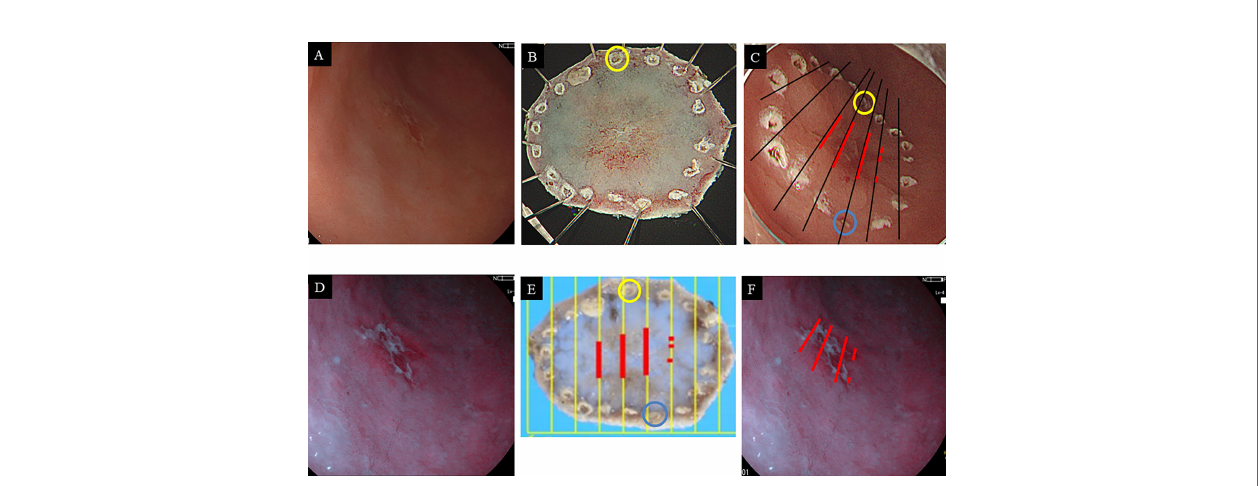
FIGURE 4 | Endoscopic images of gastric cancer on the anterior wall of the antrum with white light imaging (A) and 5-ALA PDD (B) . Macroscopic fi ndings of the resected specimen by endoscopic submucosal dissection before formalin fi xation (C) and after formalin fi xation (D) . Each blue and yellow circle in panels (C, D) corresponds to a respective circle in the endoscope image (E) . The red lines correspond to the extent of cancer cells. The cancerous horizontal extent in histopathology may be coincident with the PDD-positive area (F)